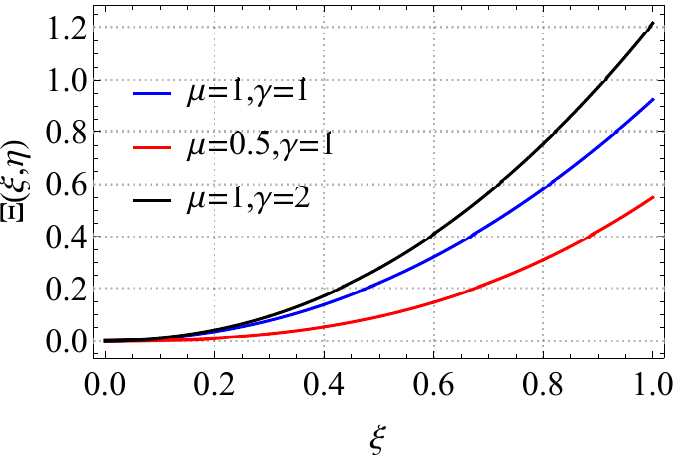
Figure 1. Graph of the exact solutions of Model 1, with α = 0.3 and m = 6, and for different values of µ and γ .